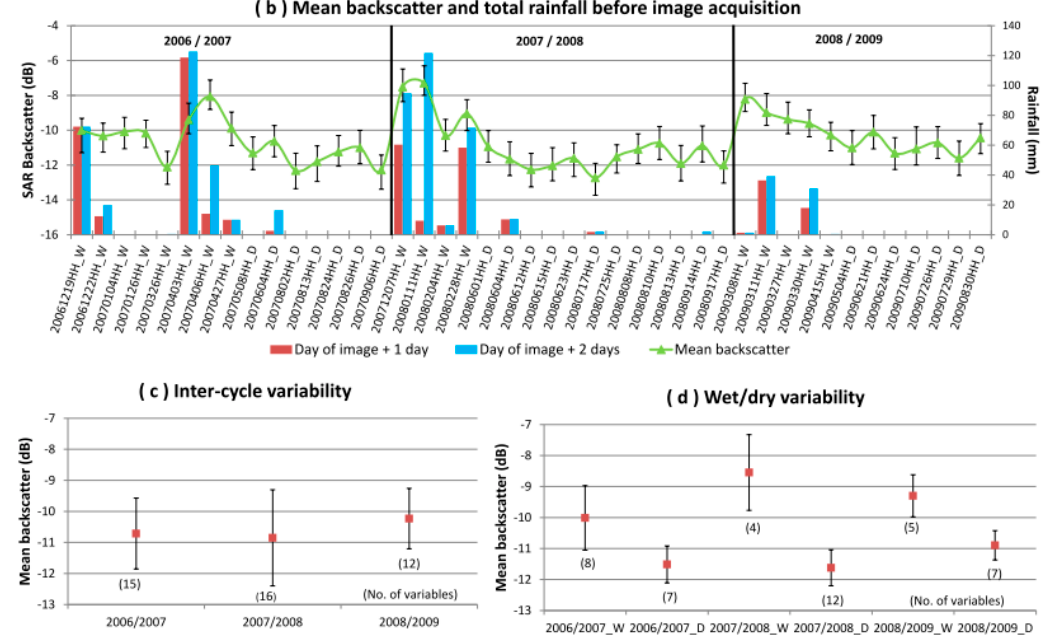
Figure 2. ( a – d ): Backscatter response to moisture in the landscape. The following is represented: ( a ) the mean backscatter per image and the total rainfall (i) per month and (ii) per month in which the image was acquired; ( b ) the mean backscatter and the total rainfall for the day of, plus one and two days prior to, image acquisition; ( c ) the inter-cycle mean backscatter values and associated variability (i.e., standard deviation); ( d ) and the mean backscatter values and associated variability between each wet and dry period. Months without images are labelled with the year and month accordingly (e.g., October 2006). Bracketed numbers represent the number of images in a series.